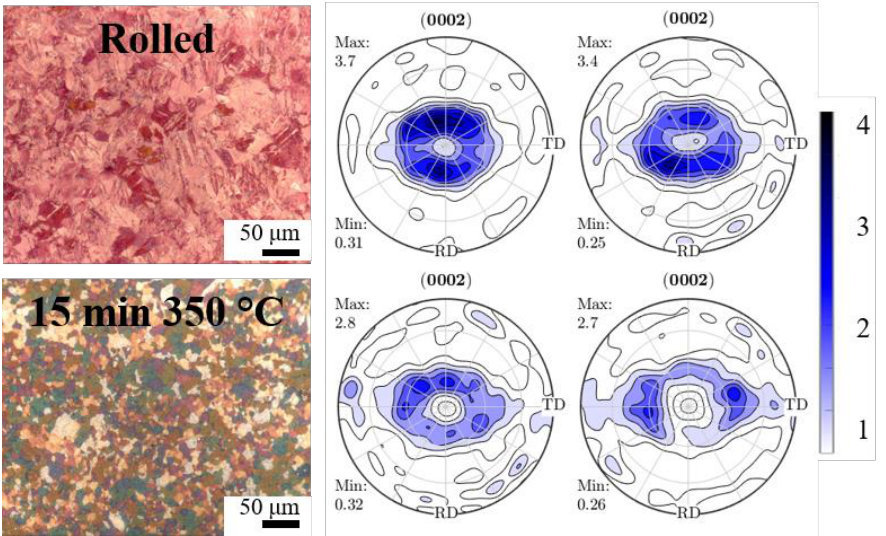
Figure 4. Texture evolution during recrystallization of Mg-1%Er-1%Zn annealed at 350 °C for 0, 5, 7, and 15 min.